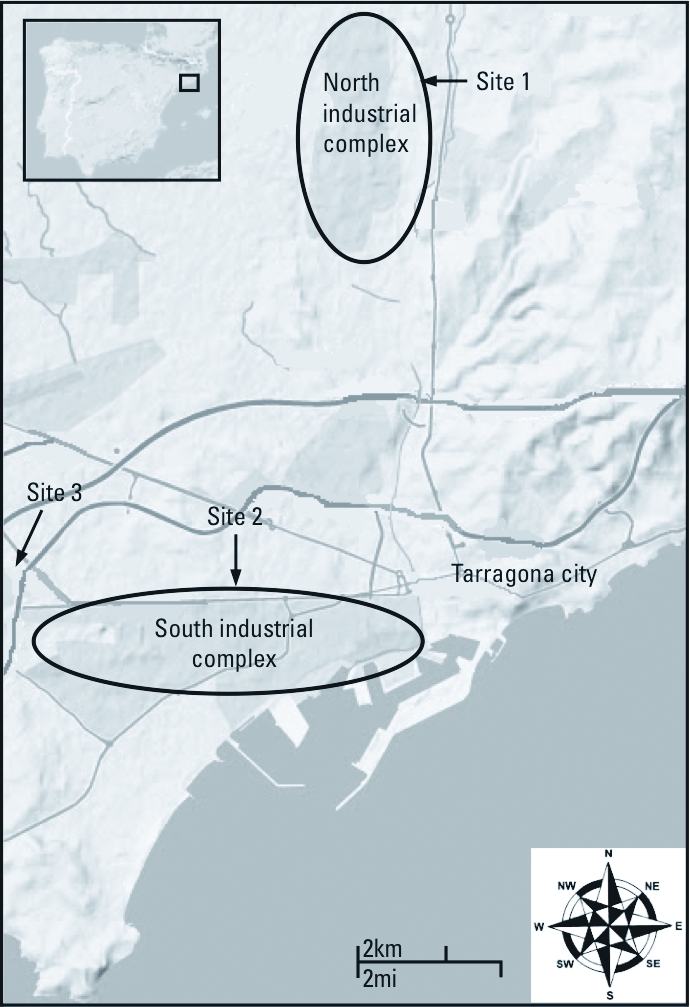
Map of the Tarragona region showing the location of the main city (Tarragona), the North and South Industrial Complexes, and the three sampling points: site 1 (Perafort-Puigdelfí) near the North Industrial Complex and site 2 (Tarragona-Bonavista) and site 3 (Vila-seca) near the South Industrial Complex.